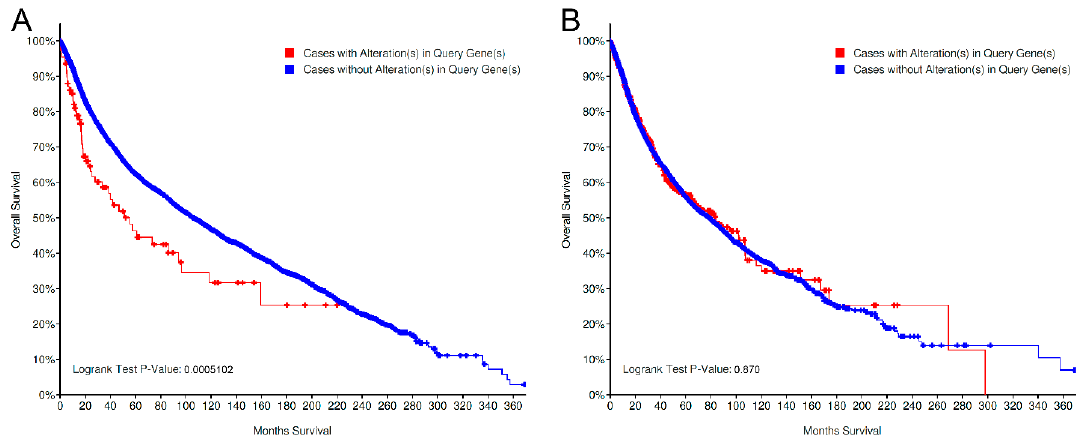
Figure 6. Prognostic significance of LRRK2 CNV-altered vs. CNV-unaltered cases ( A ) and in MUT-altered vs. MUT-unaltered cases ( B ). A significant difference is noted for cases analyzed for CNVs, but not for cases profiled for MUTs [48–50]. MUT: point mutations, indels and fusions; CNV: copy-number variations.